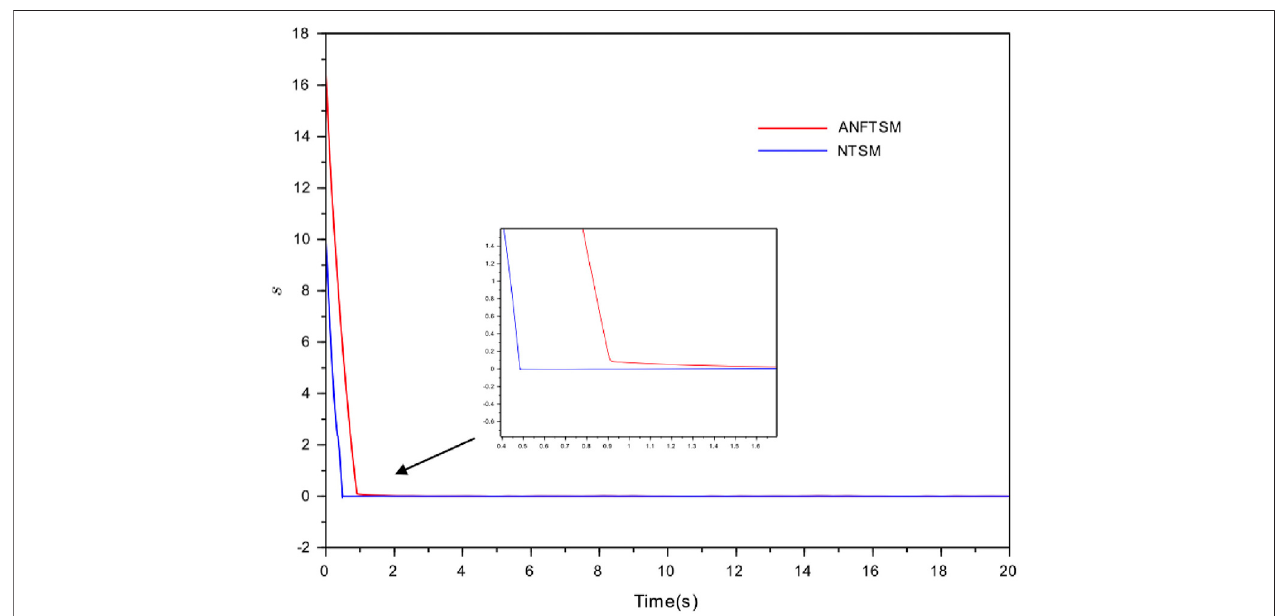
FIGURE 5 | Sliding surface for Example 1.